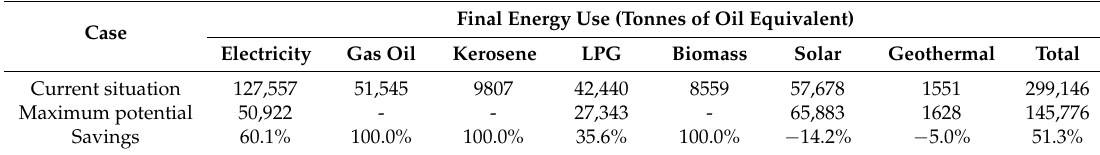
Table 3. Maximum theoretical energy saving potential for the Cypriot residential